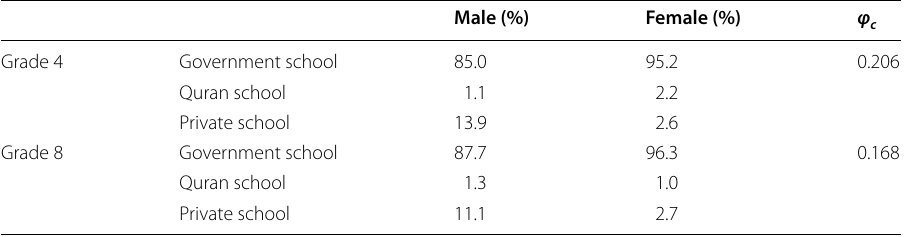
All differences are statistically significant at the .001